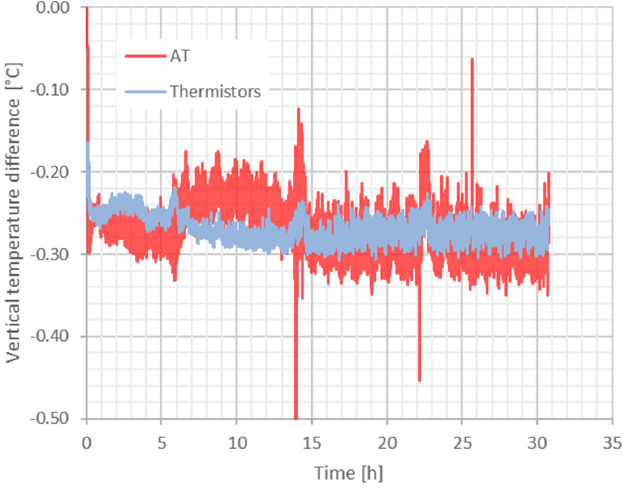
Figure 10. Temperature at two distances from the floor (1 m and 1.5 m) during a period of about 30 h when the stabilization circuit of the laboratory is switched off. ( a ) The temperature measured with the acoustic thermometers (AT) along a distance of 26 m. ( b ) the temperature measured in the same area with a series of 20 thermistors distributed along the path.